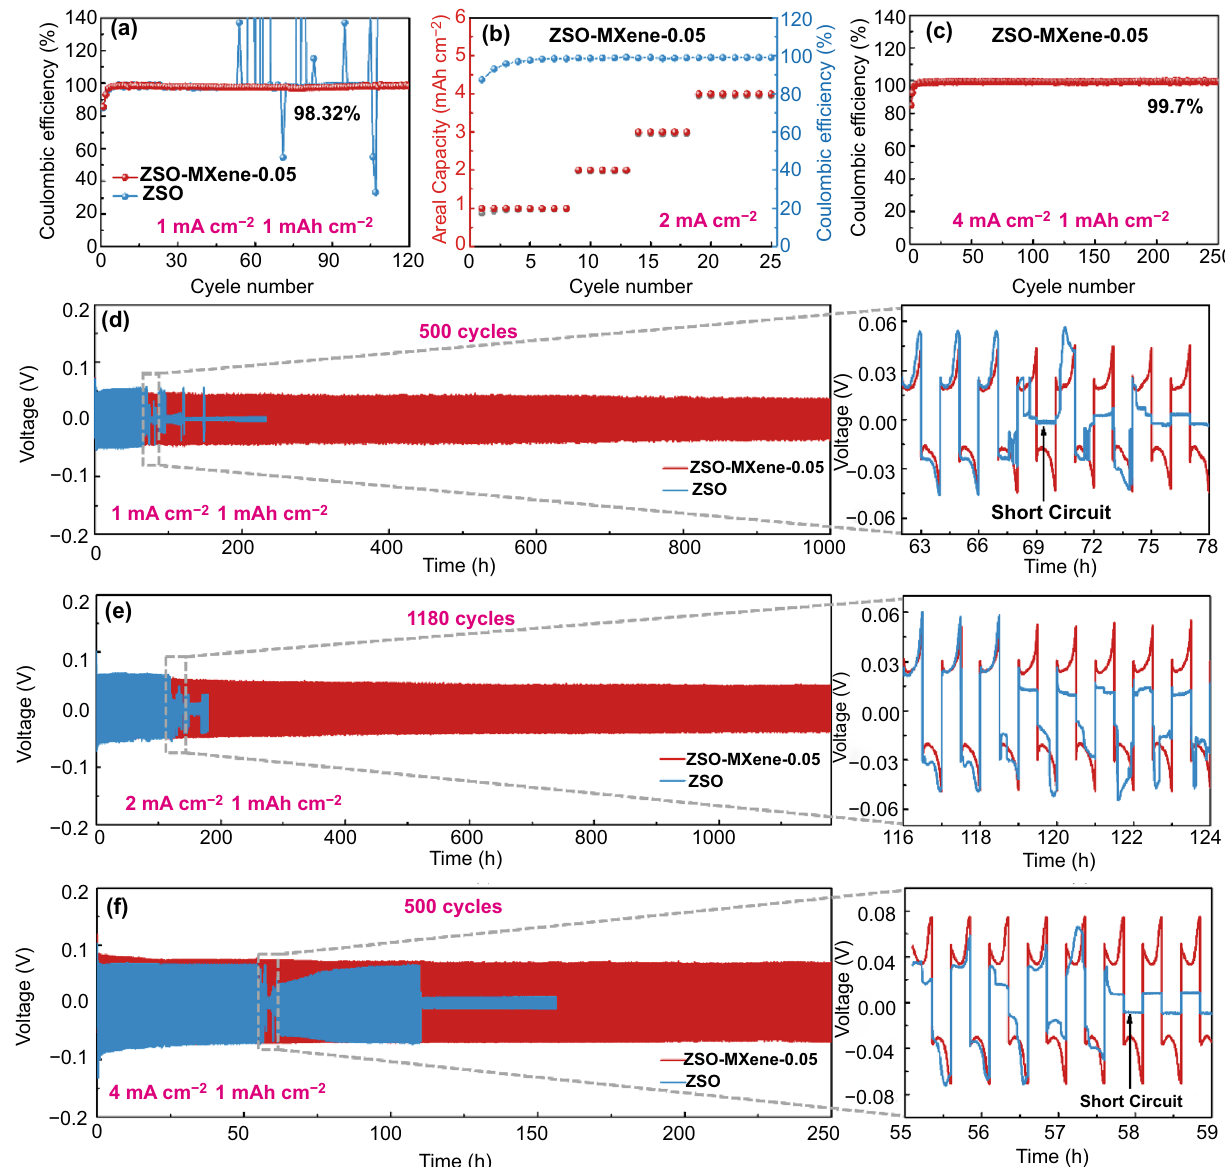
Fig. 3 ( a ) Coulombic efficiency of the Zn plating/stripping at 1 mA cm −2 with the capacity of 1 mAh cm −2 . b Coulombic efficiencies of the Zn plating/stripping at 2 mA cm −2 with the capacity of 1, 2, 3 and 4 mAh cm −2 . c Coulombic efficiencies of the Zn plating/stripping at 4 mA cm −2 with the capacity of 1 mAh cm −2 . d‑f Long-term galvanostatic cycling of Zn-Zn symmetrical cell at 1, 2 and 4 mA cm −2 with the capacity of 1 mAh cm